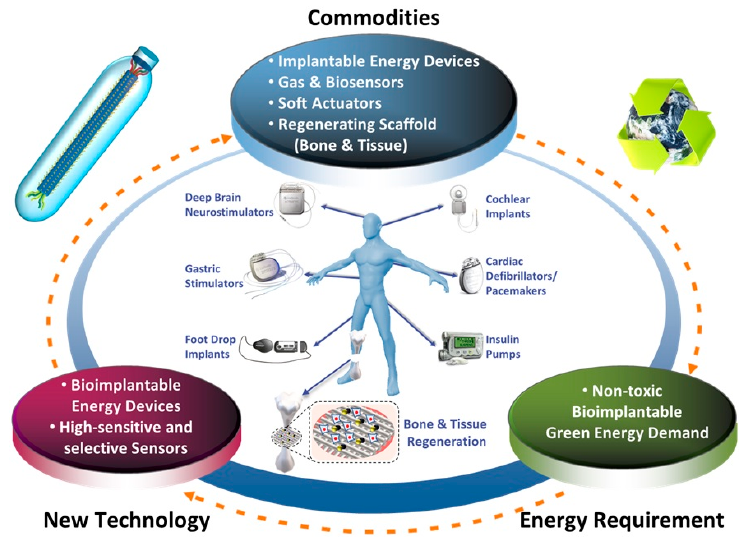
Figure 9. Schematic diagram showing the practical applications of M13 bacteriophage-based piezoelectric energy harvesting devices in the future.